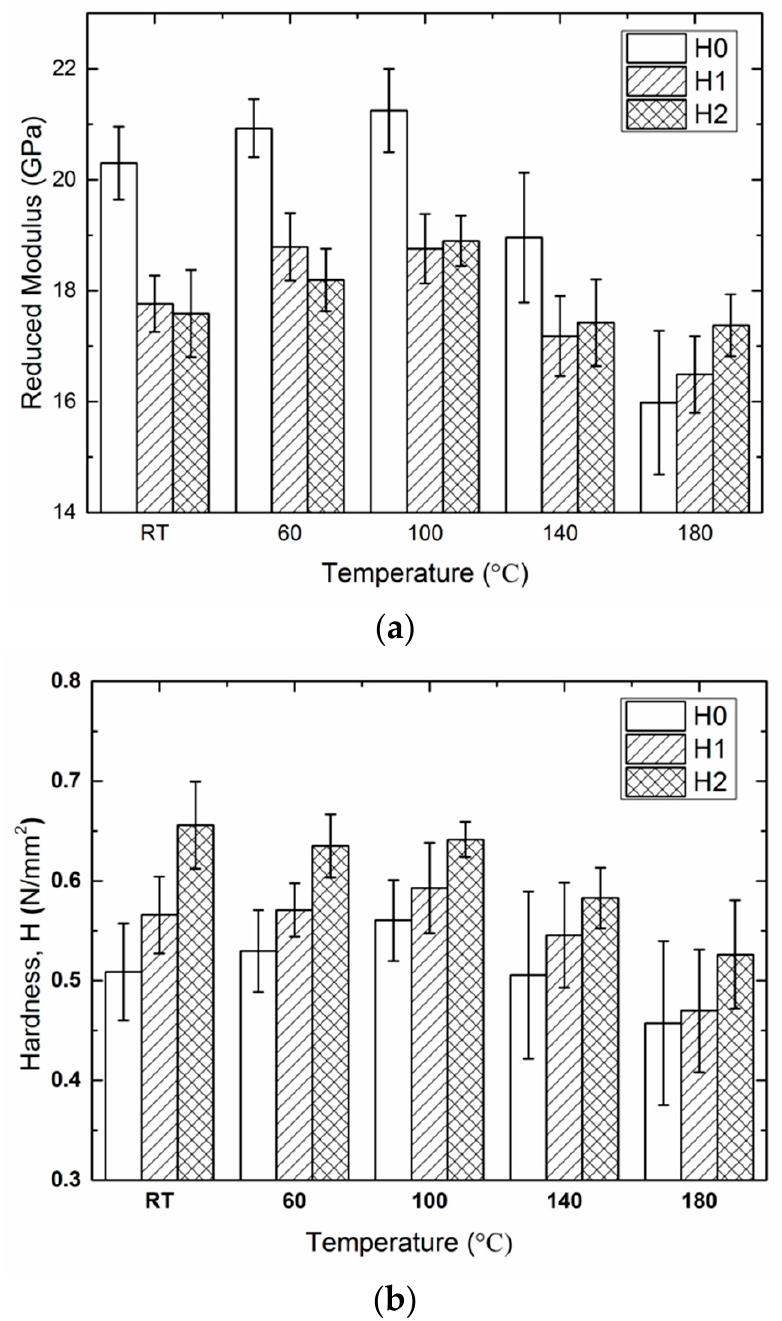
Figure 5. ( a ) The reduced modulus of heat-treated and untreated wood cell wall; ( b ) the hardness of heat-treated and untreated wood cell